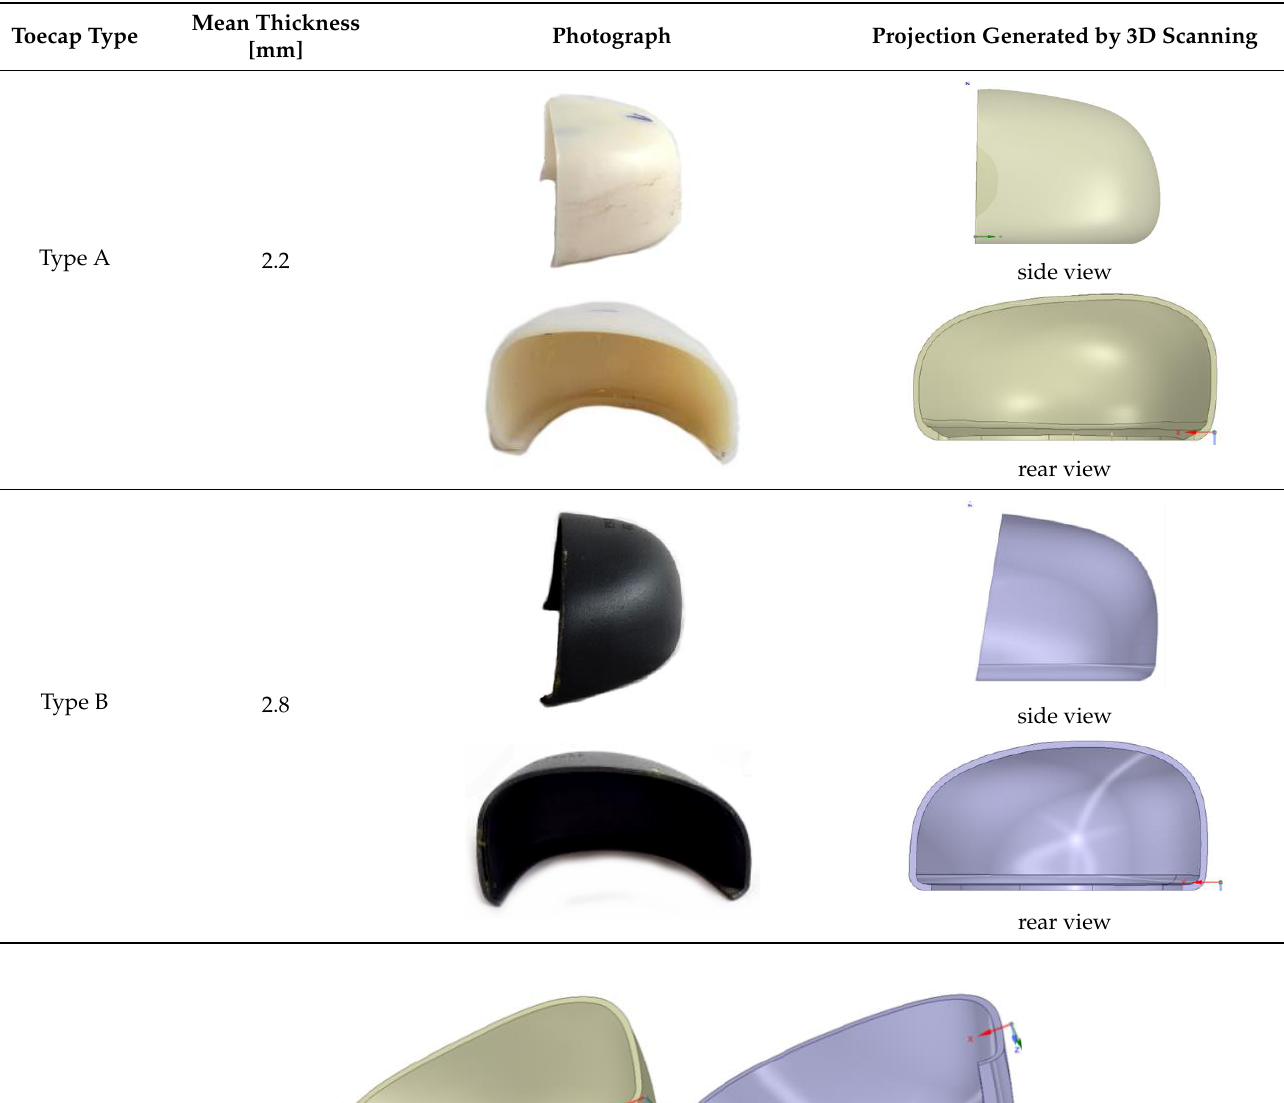
Table 1. Tested toecaps.